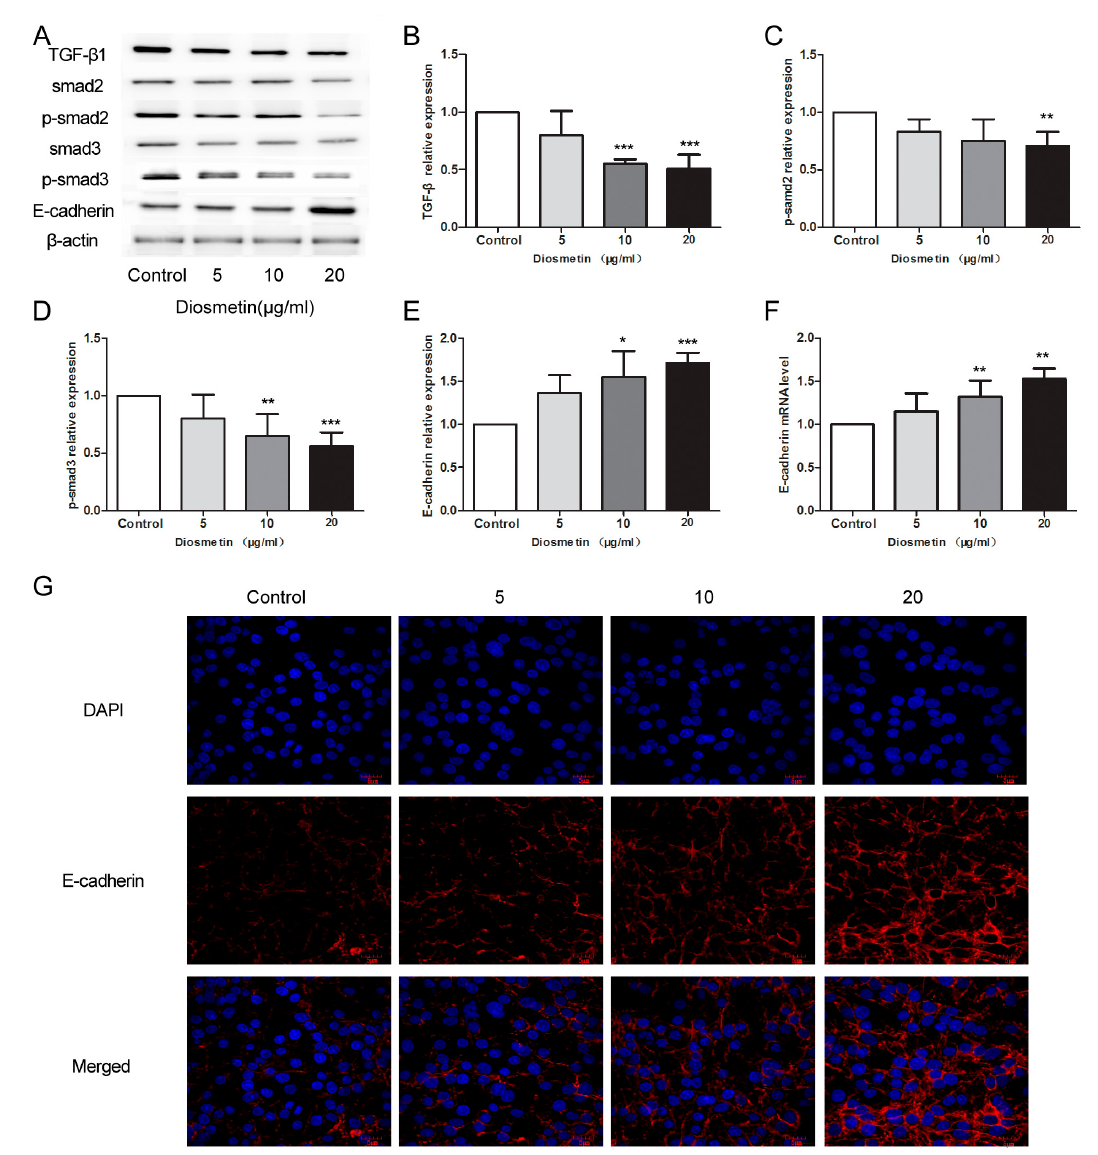
Figure 4. Diosmetin led to inhibition of the TGF- β signaling pathway and activation of E-cadherin expression in glioma cells. Western blot assay was performed to detect the protein levels of ( A , B ) TGF- β 1, ( A , C ) p-smad2, ( A , D ) p-smad3 and ( A , E ) E-cadherin, with the grayscale analysis using β -actin as the internal control. ( F ) Real-time PCR was used to detect the expression level of E-cadherin mRNA. ( G ) Immunofluorescence staining was performed to observe the distribution of E-cadherin protein in glioma cells. Compared with control group, * p < 0.05, ** p < 0.01, *** p < 0.001.